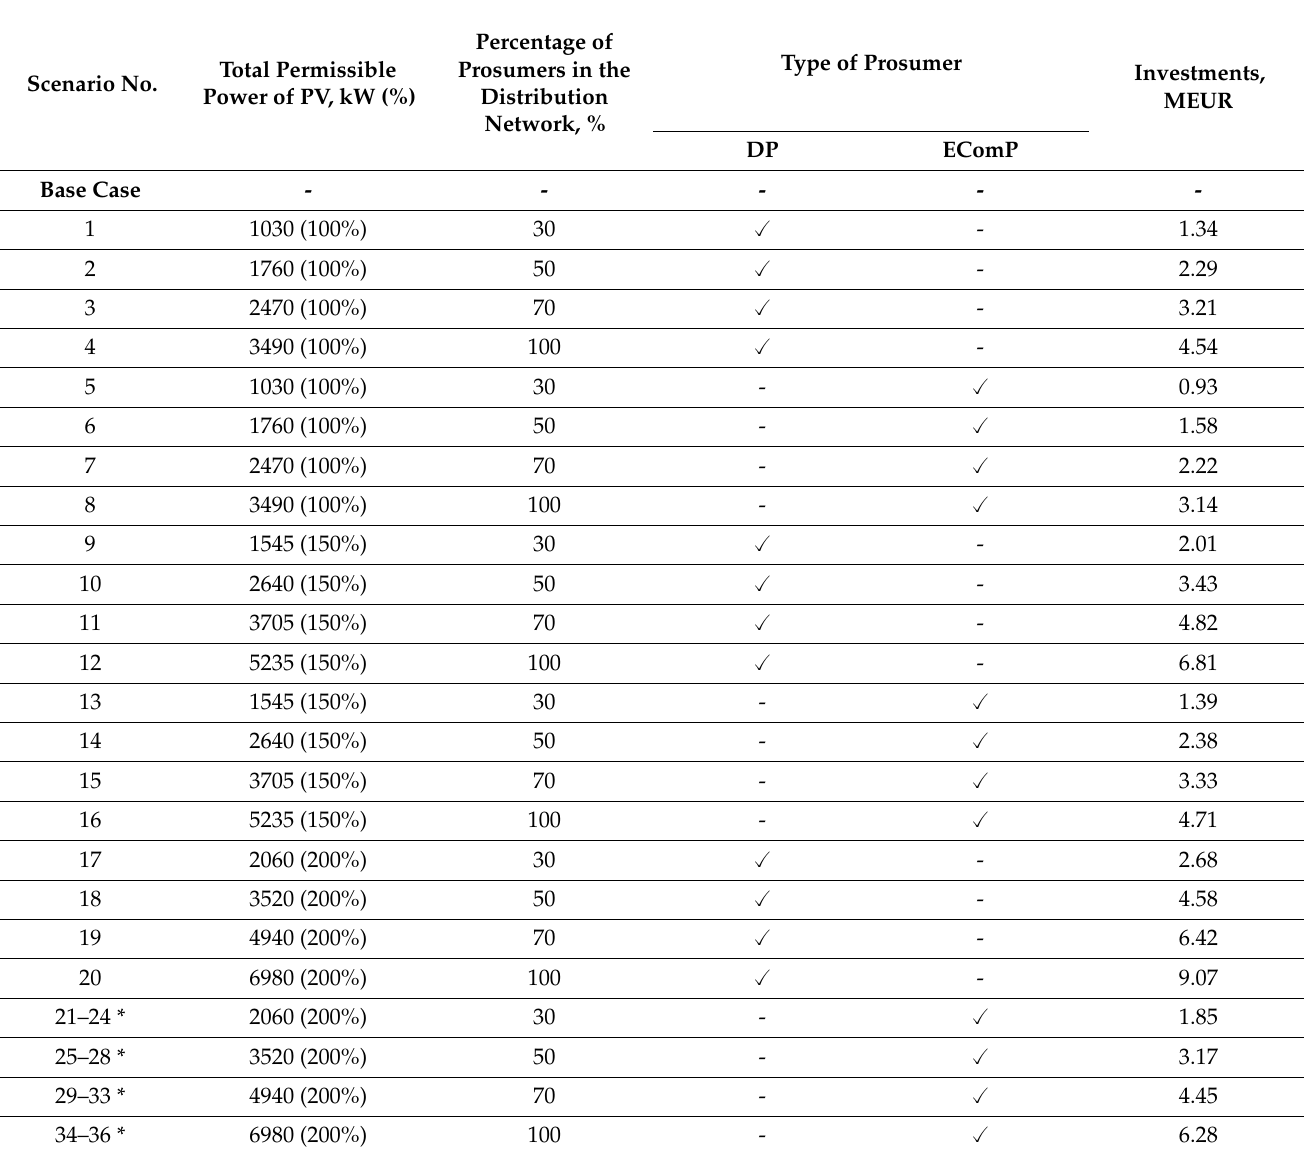
Table 1. Description and installed PV capacities per phase for the studied cases (“ option; “-“ is a not selected